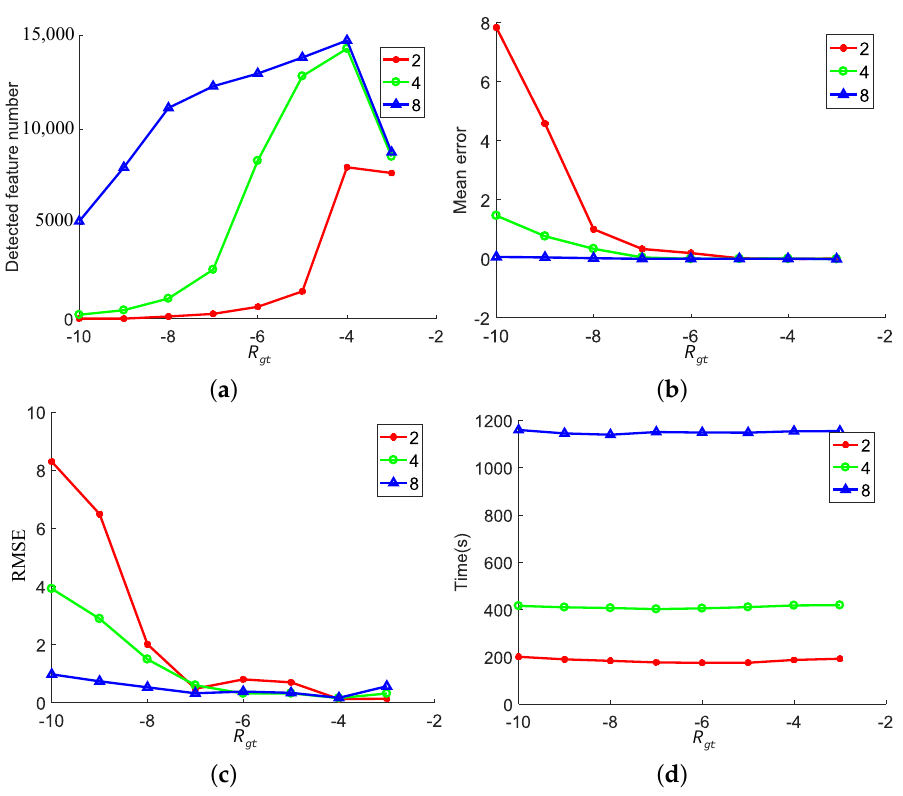
Figure 10. Detected results of proposed algorithm using multi-layer CPSFS on simulated raw images. ( a ) The number of detected features with regard to R gt . ( b ) Mean error of detected features’ plenoptic disc radius (dimensionless). ( c ) RMSE of detected features’ plenoptic disc radius (dimensionless). ( d ) Total detection time of 20 independent experiments.